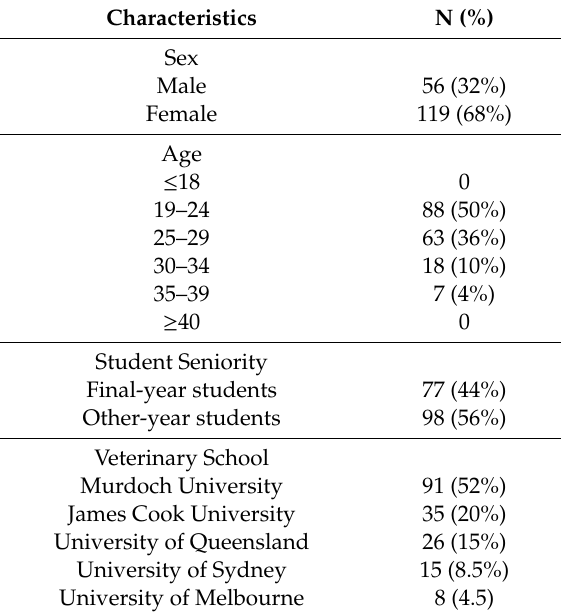
Table 2. Demographic characteristics of the 175 senior veterinary student survey